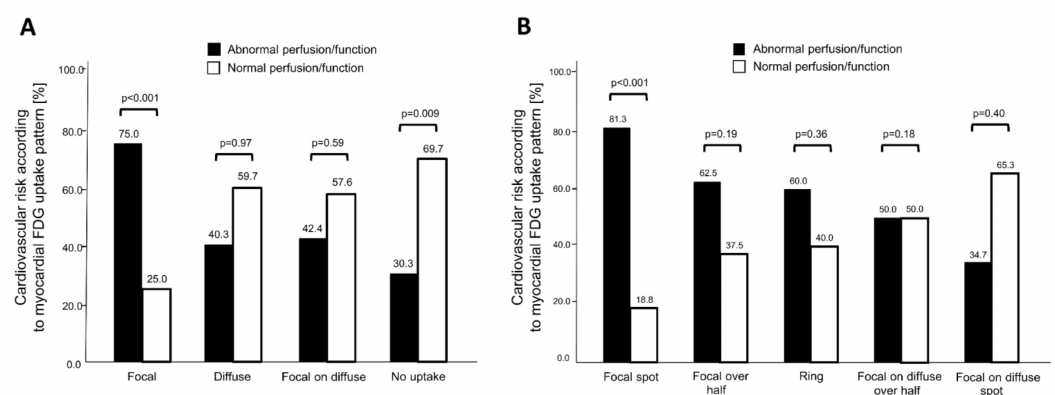
Figure 2. Cardiovascular risk according to myocardial uptake pattern of 18 F-FDG-PET / CT. Patients were stratified by normal / abnormal myocardial perfusion imaging (MPI) findings. The Y-axis depicts the percentage of patients with abnormal and normal myocardial perfusion / function, respectively, in each subpopulation of distinct myocardial uptake pattern. The total number of patients within a subpopulation is set as 100%. ( A ) While focal myocardial 18 F-FDG uptake was predominantly observed in patients with abnormal perfusion and function, patients with no myocardial 18 F-FDG uptake more frequently presented with normal cardiac perfusion / function. ( B ) Dividing focal and focal on di ff use patterns into subgroups revealed that the focal spot pattern further improved risk prediction for cardiac